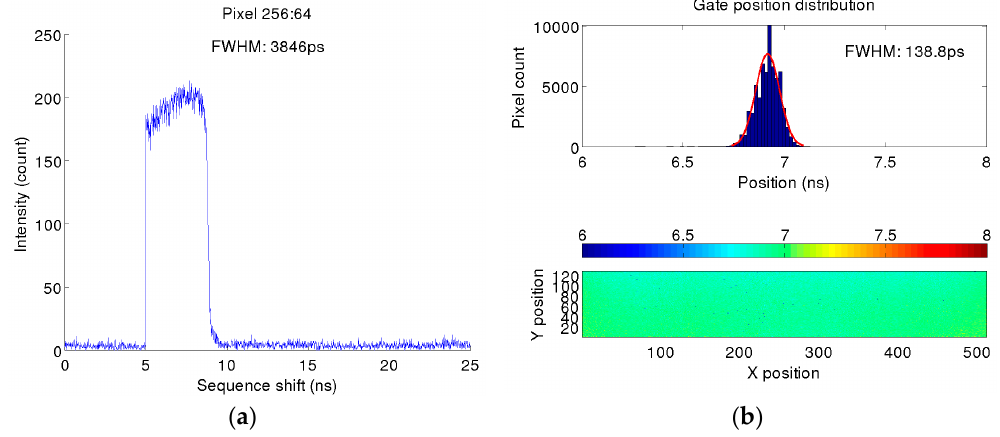
Figure 13. Timing characterization of the gating mechanism: ( a ) characteristic sensitivity at the minimum gate width of 3.8 ns; ( b ) gate position (in time) statistics as a function of pixel position [23].